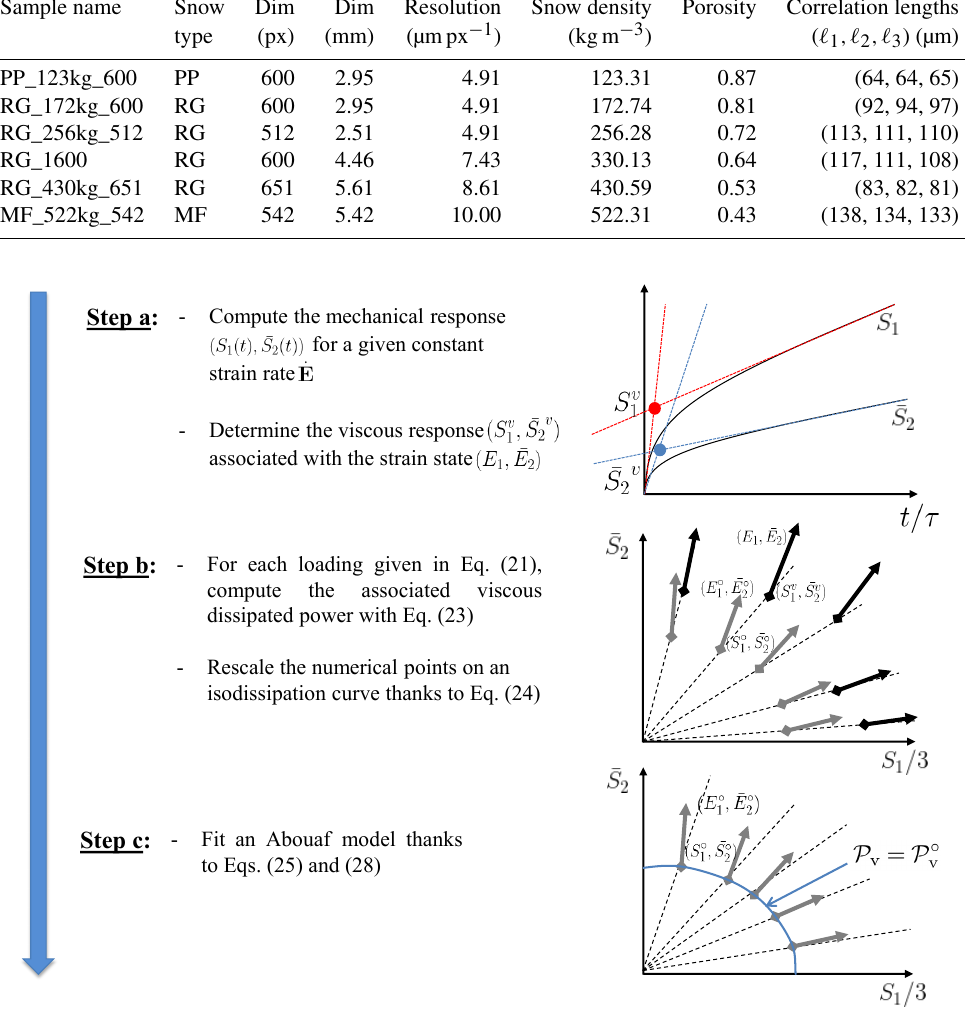
Figure 2. Three-step post-processing procedure used in order to formulate a homogenized viscous constitutive